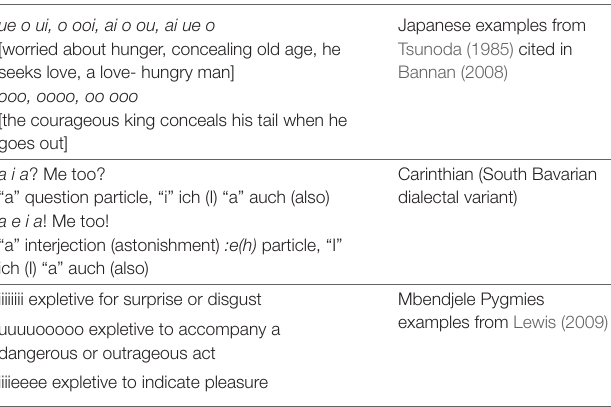
TABLE 1 | Examples of vowel-only sentences and vowel-only expletives in Japanese, Carinthian and in the language of the Mbendjele Pygmies. ue o ui, o ooi, ai o ou, ai ue o [worried about hunger, concealing old age, he seeks love, a love- hungry man] ooo, oooo, oo ooo [the courageous king conceals his tail when he goes